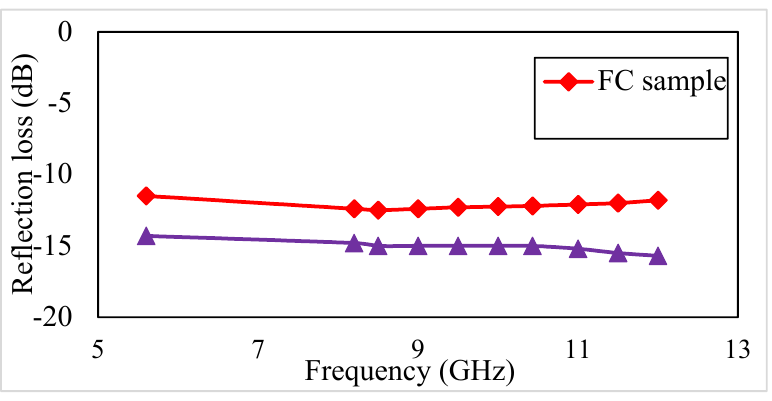
Figure 7. Reflection loss curves of the FAC and FC samples.